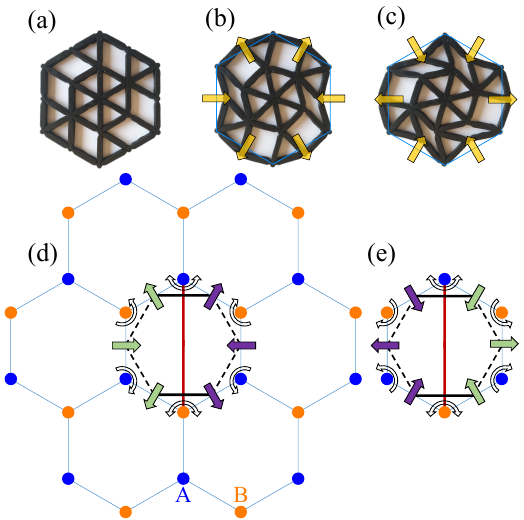
Figure 1: (a) 2D hexagonal building block, (b) the extended 2-in-4-out, and (c) the contracted 4-in-2-out states of its soft deformation mode, which does not stretch or compress the constituent links. (d,e) Vertices of sublattices A and B are marked in blue and orange respectively. Ising spins are assigned to the deformation arrows according to the winding direction around the two sublattice vertices: ± 1 spins are indicated in purple and green. Spin of two adjacent facets is preserved (flipped) if deformations wind in the same (opposite) direction with respect to the common vertex between them, as indicated by the circular arrows. Resulting ferromagnetic (antiferromagnetic) interactions are indicated by dashed (solid) lines connecting the two facets. Red director line drawn perpendicular to the antiferromagnetic bonds designates the orientation of the building